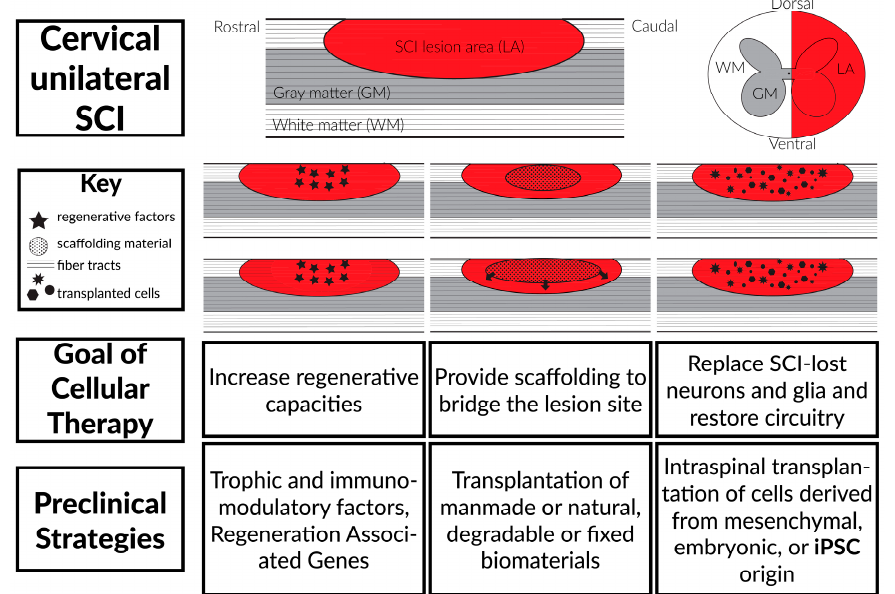
Figure 3. Current SCI therapeutics are calibrated to increase the regenerative capacities of the lesion site, provide a bridge through the lesion site to promote reconnection of rostral and caudal central nervous system (CNS), and to replace SCI-lost neurons and glia via transplantation of mesenchymal, embryonic, and induced pluripotent stem cells (iPSCs).